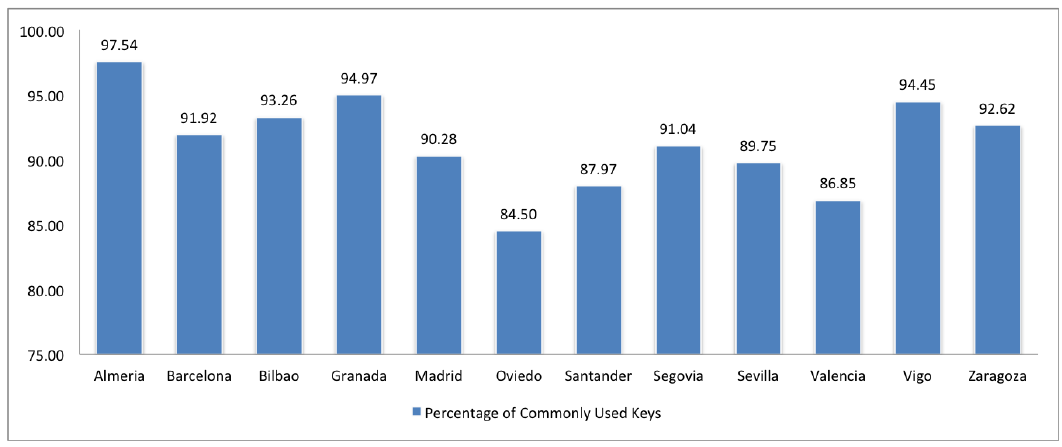
Figure 7. Compliance study in Spain. Percentage of commonly used keys.